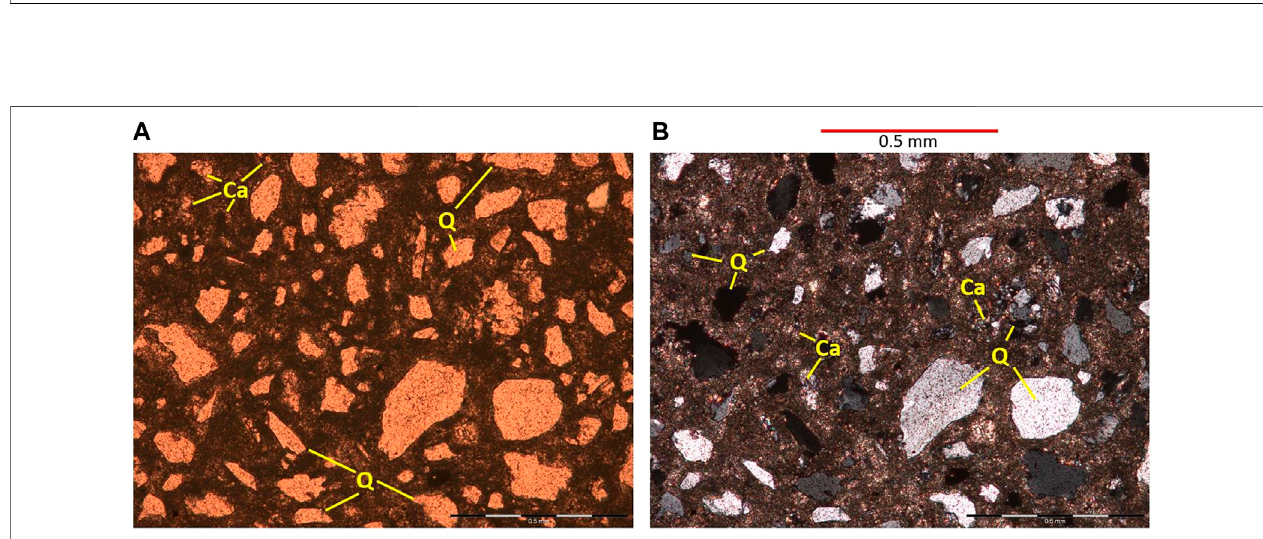
FIGURE 6 | Thin section image of variegated mudstone from the MPC 34-1 well, Paluxy Formation, 1,621.5 m (5,319.9 ft). (A) Plane-polarized light (PPL) photomicrograph with calcite (Ca) and Quartz (Q). (B) Cross- polarized light (CPL) photomicrograph.